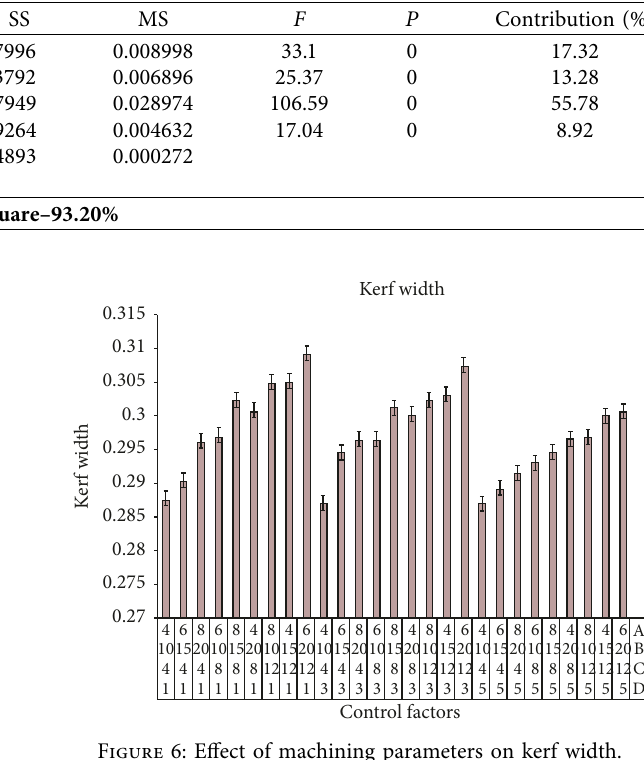
Table 4: ANOVA table for surface